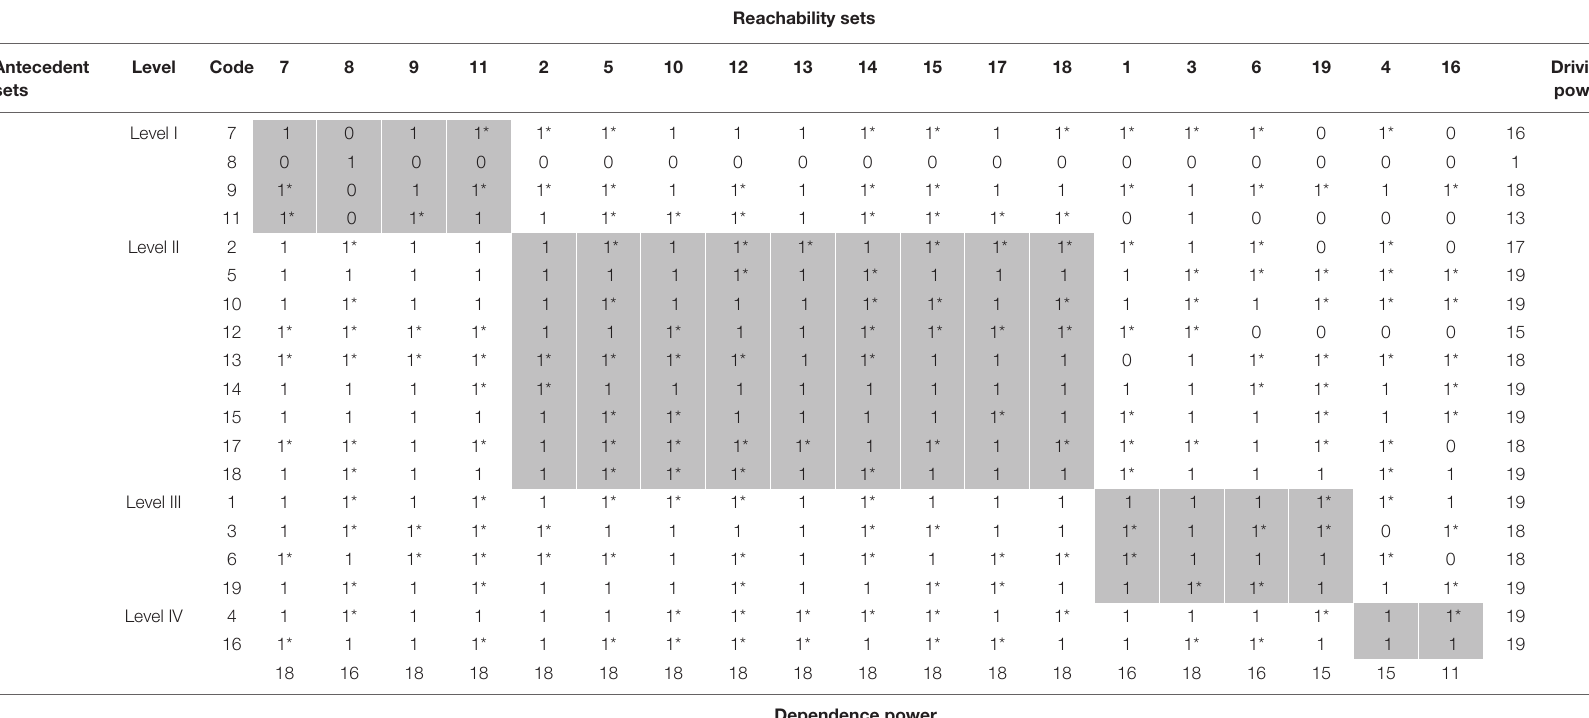
TABLE 5 | Abridged representation of interpretive structural